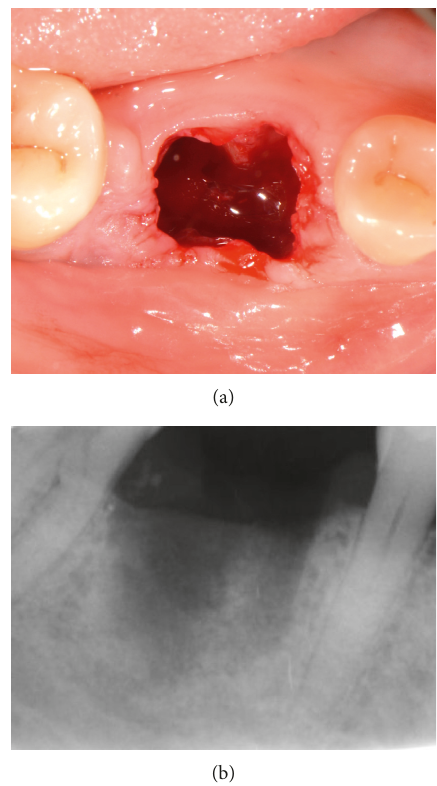
Figure 2: Clinical view and periapical X-ray of the site immediately after the “atraumatic” flapless extraction. The septal bone is completely missing, and the buccal bone was defective. Note the shortage of buccal keratinized soft tissue.